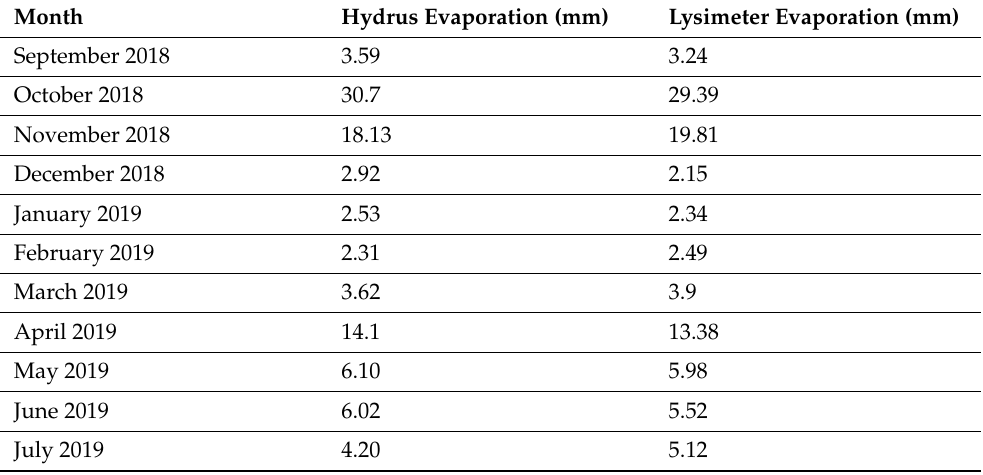
Table 5. Monthly evaporation based on the Hydrus model and compared to lysimeter